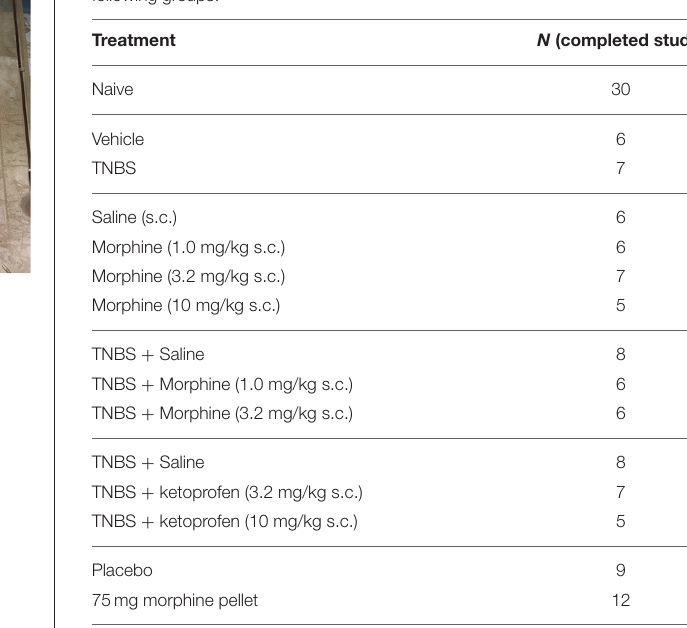
TABLE 1 | Nesting was determined in mice randomly assigned to the following